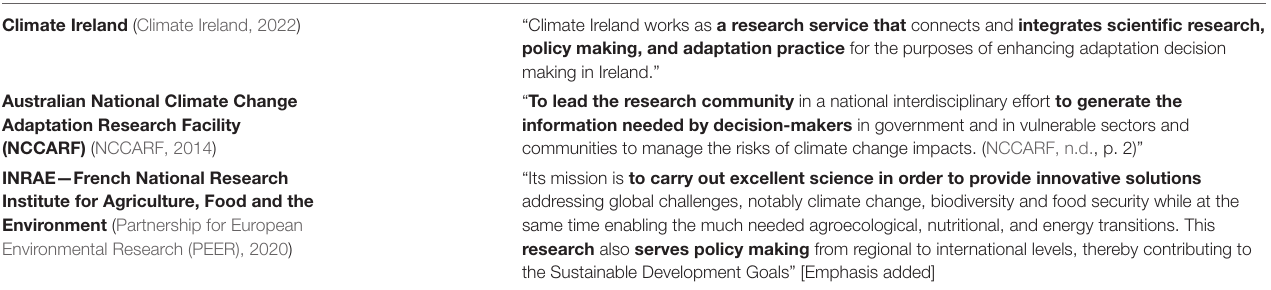
TABLE 1 | Examples of a science-driven approach to evidence development for climate change policy. Climate Ireland (Climate Ireland, 2022) “Climate Ireland works as a research service that connects and integrates scientific research, policy making, and adaptation practice for the purposes of enhancing adaptation decision making in